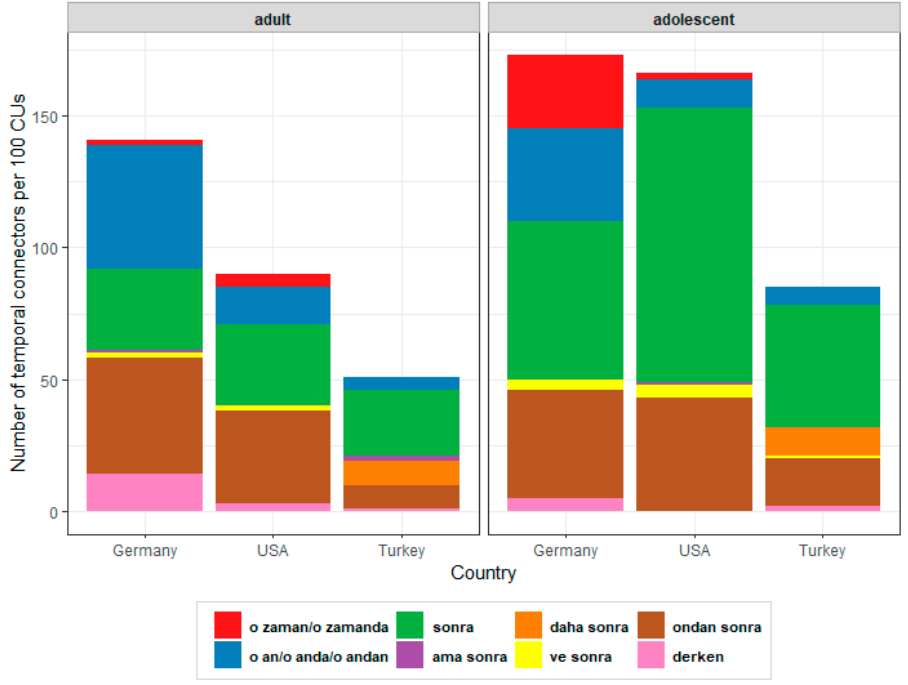
Figure 5. Bar plots representing the number of temporal connectors per 100 CUs.